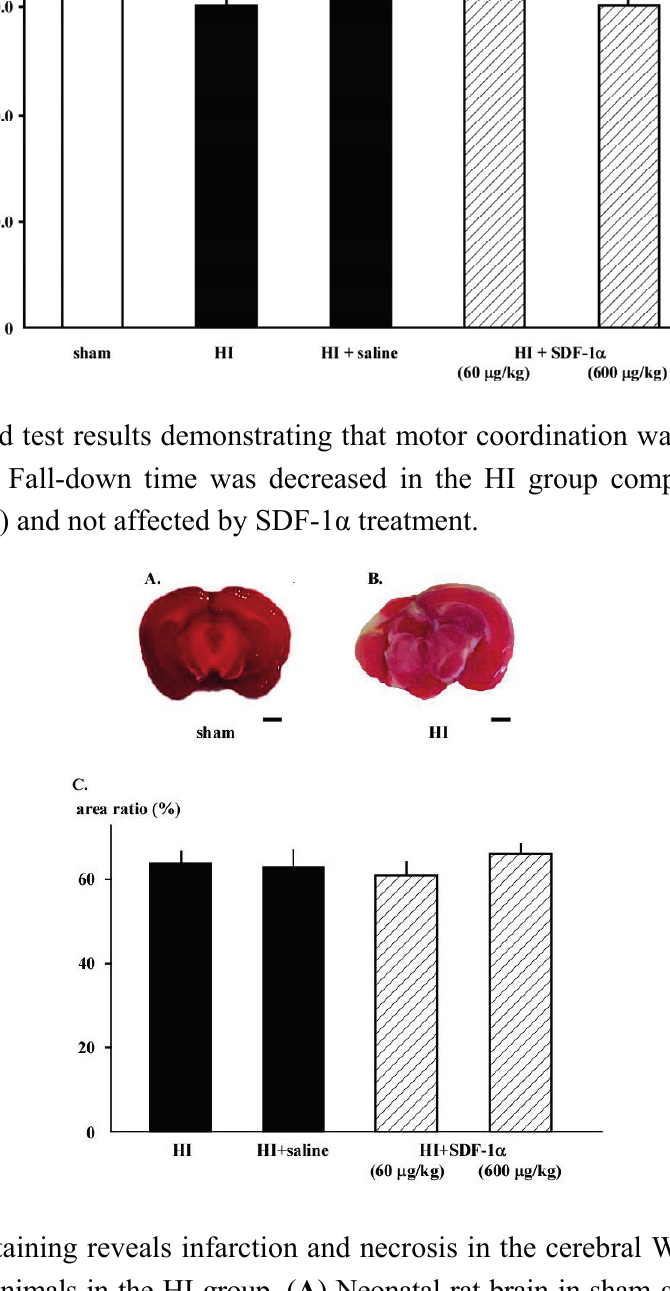
Figure 4. TTC staining reveals infarction and necrosis in the cerebral WM and around the hippocampus of animals in the HI group. ( A ) Neonatal rat brain in sham group demonstrates normal appearance; ( B ) Cerebral infarction was demonstrated in the ligated side of the brain as an atrophic and destructive area; and ( C ) SDF-1 α did not change the infarct area in HI group. Bar is 1